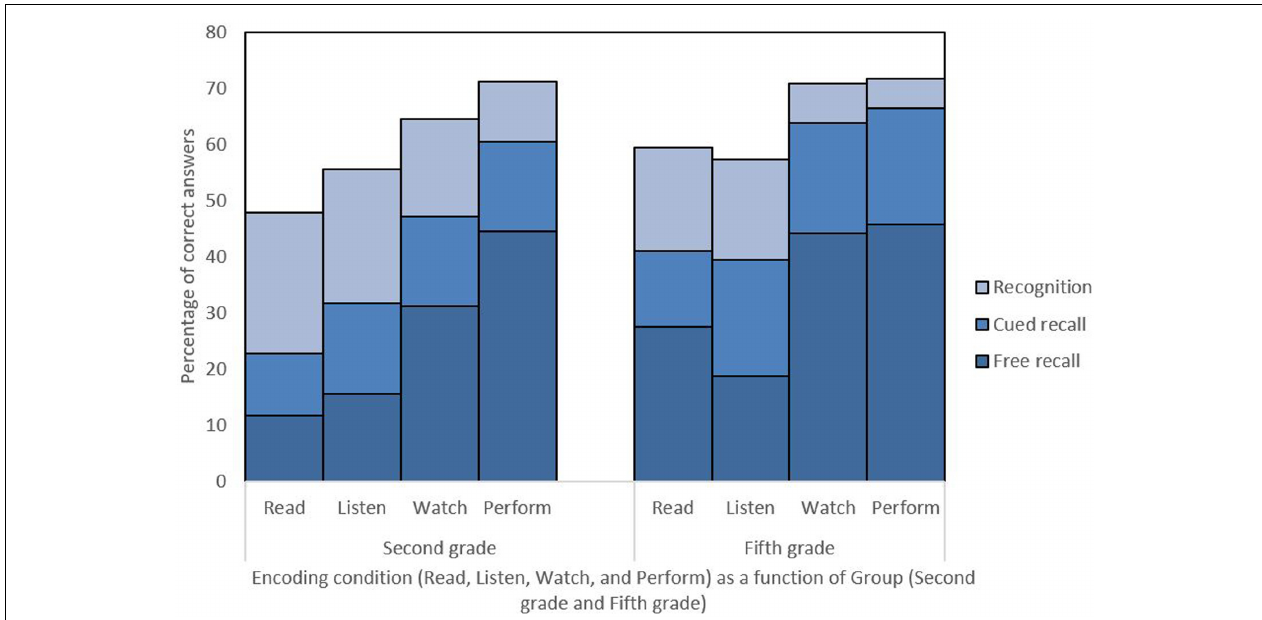
FIGURE 3 | Percentage of correct answers of action events recalled as a function of type of encoding condition (Read, Listen, Watch, Perform), Group (Second Graders and Fifth Graders), and Retrieval phase (Free Recall, Cued Recall, Recognition).